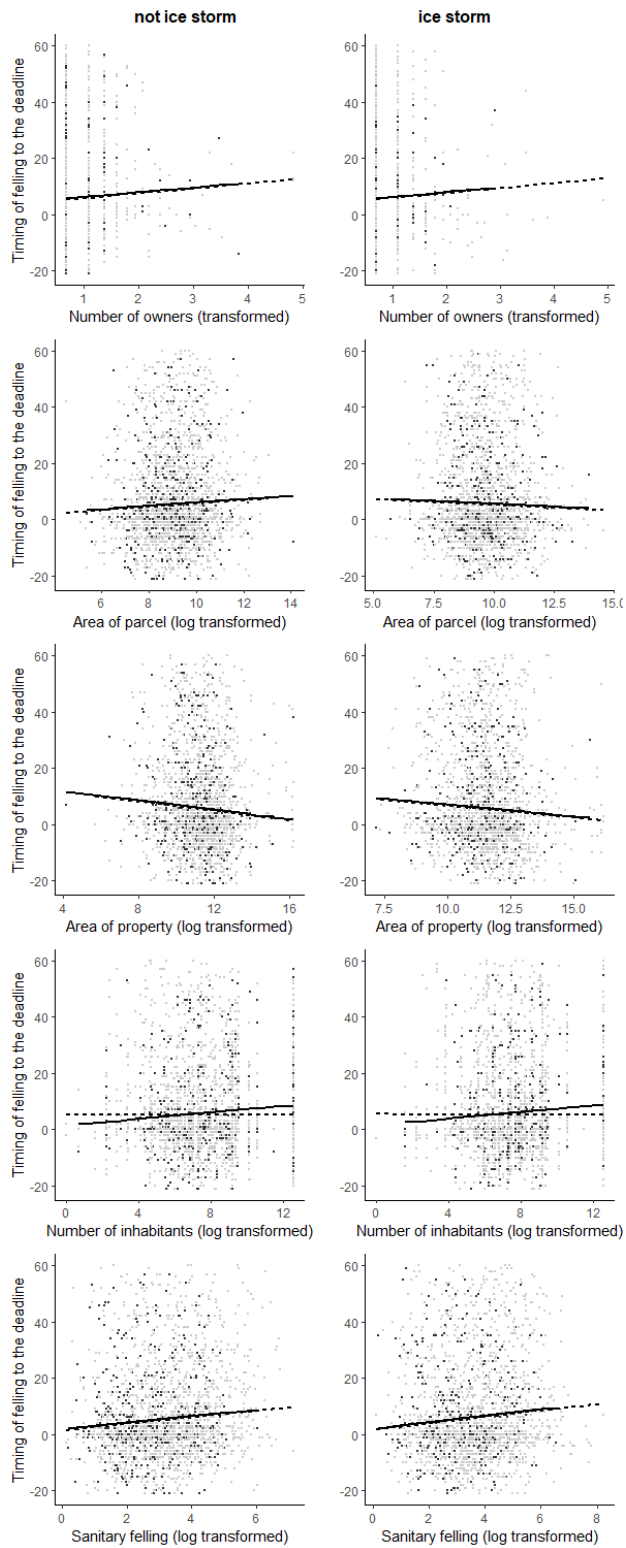
Figure 2. Associations of the different characteristics of the privately owned parcels with the presence of the ice storm and the amount of spruce with the timing of felling in the summer period. The grey dots and the black dashed line show a high amount of spruce and the black solid line and black dots show a low amount of spruce.